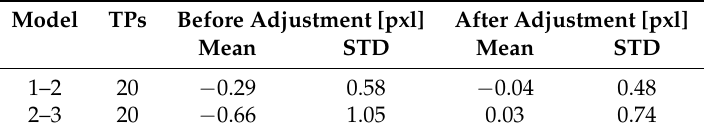
Table 9. Statistics on the deviation of tie-points orthogonal to the epipolar direction given in pixels for the Innsbruck East Triplet.